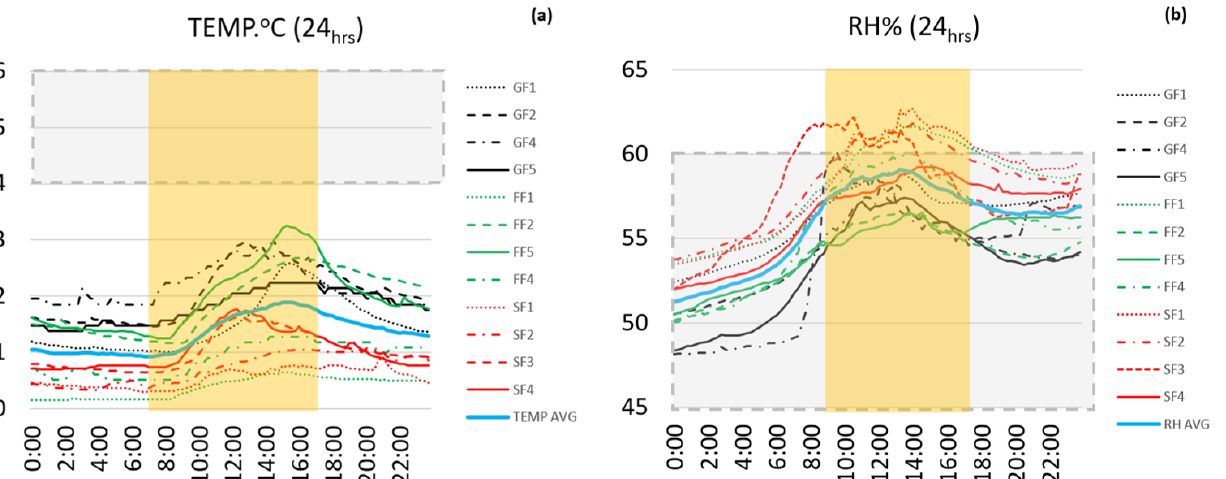
Figure 5. Temperature ( a ) and RH ( b ) December to February profiles. The blue line indicates aver- age, and the grey box indicates recommended thresholds. 3.1.2. Indoor Air Quality The IAQ assessment was covered by recording spot measurements of the concentra- tions of PM2.5, PM10, CO 2 , and TVOCs in the air. There were no major flaws exhibited by the results; however, design factors and occupant behavioural trends have been noted. The box plots in Figure 6a–d represent each variable’s recorded measurements across 6